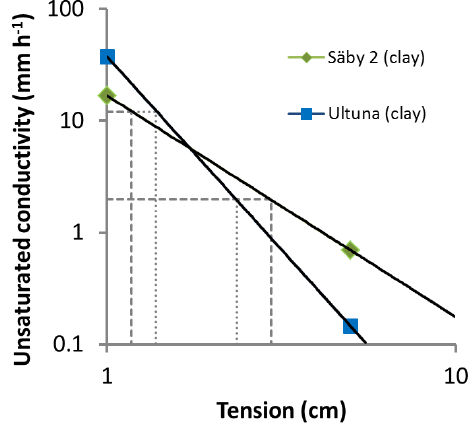
Figure 2. Determination of soil tensions corresponding to steady- state irrigation rates of 2 and 12mmh − 1 for two of the